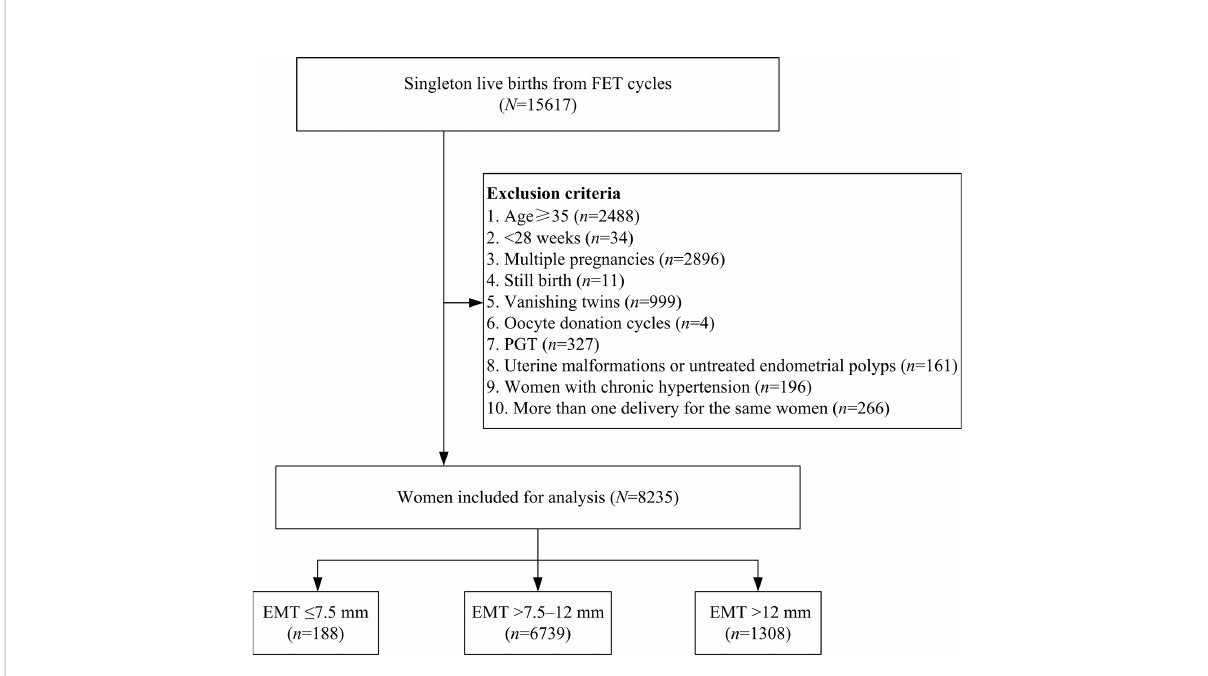
FIGURE 1 Flow chart of the